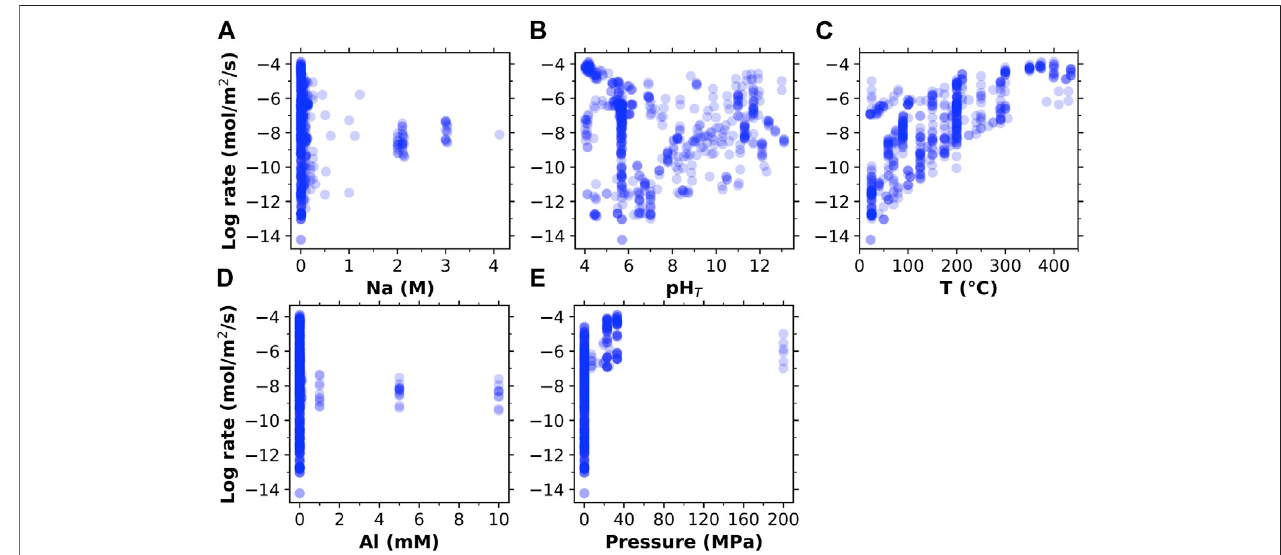
FIGURE1| Therelationshipbetweenthelogdissolutionrateofquartz(inmole/m 2 /s,basedonBrunauer – Emmett – Teller(BET)surfaceareaofquartzparticles)and the fi vedissolutionconditions (A) Na +content(in mole/L (M)), (B) pH T , (C) temperature T (in ° C), (D) Alcontent (in mM), and (E) pressure(in MPa)in themined database (as given in Supplementary Material A ).